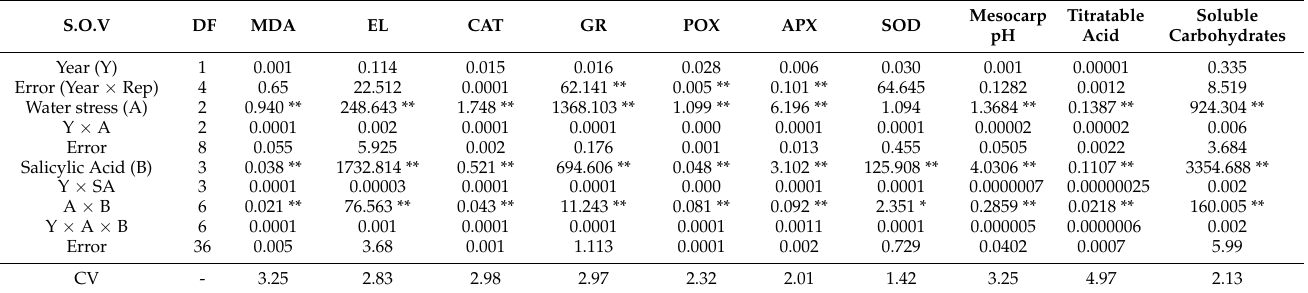
Table 3. Analysis of variance of the effect of drought stress and SA application.